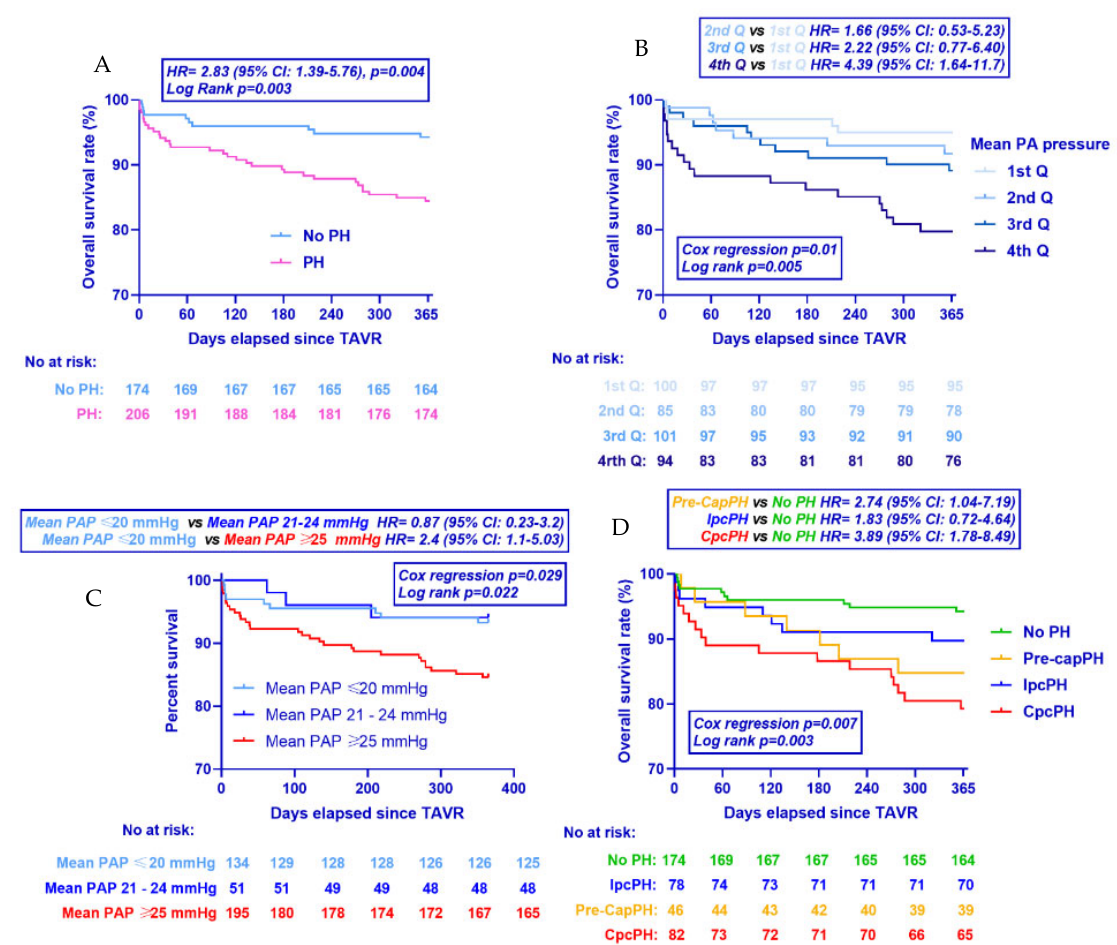
Figure 2. Kaplan–Meier curves for all-cause mortality at 1 year. Population stratified according to ( A ) whether PH was present or not, ( B ) mPAP quartiles, ( C ) the presence of mean PAP between 21 and 24 mmHg and ( D ) hemodynamic type of PH. HR: hazard ratio; p values refer to unadjusted hazard ratios from Cox regression analysis. CI: confidence intervals; TAVR: Transcatheter Aortic Valve Replacement. PH: Pulmonary hypertension; AS: Aortic stenosis; PA; Pulmonary artery.